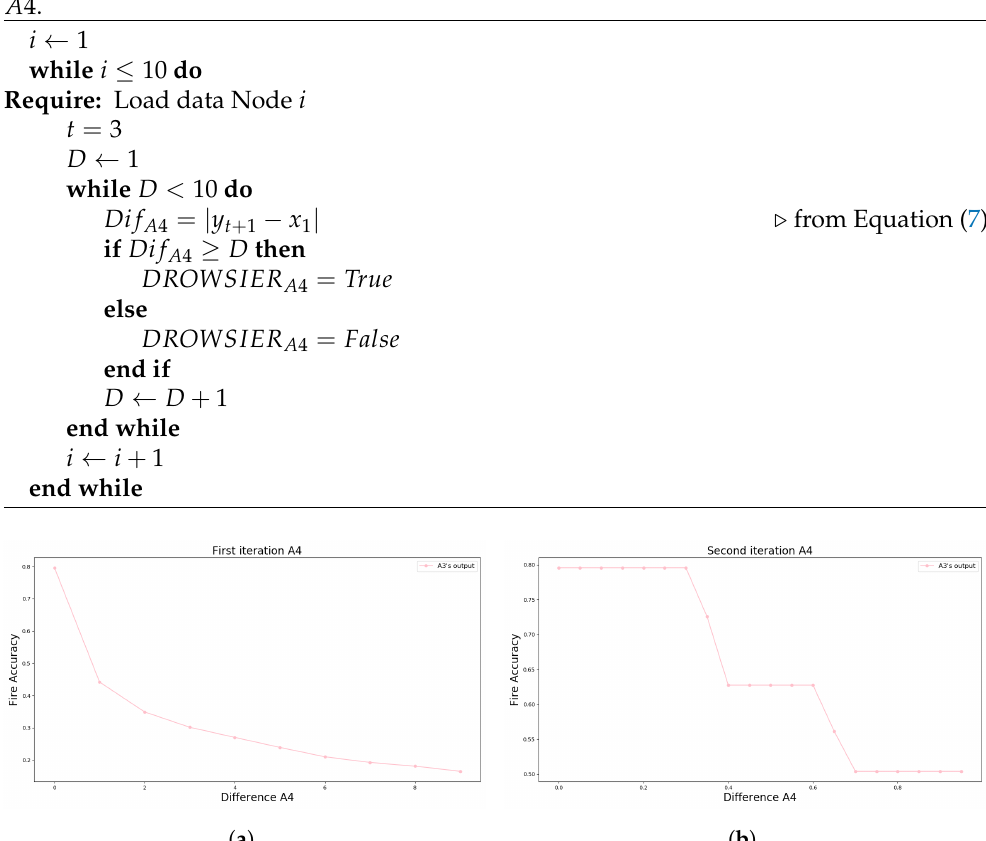
Algorithm 4 Pseudocode algorithm for testing the parameters of Least Squares algorithm— A 4.